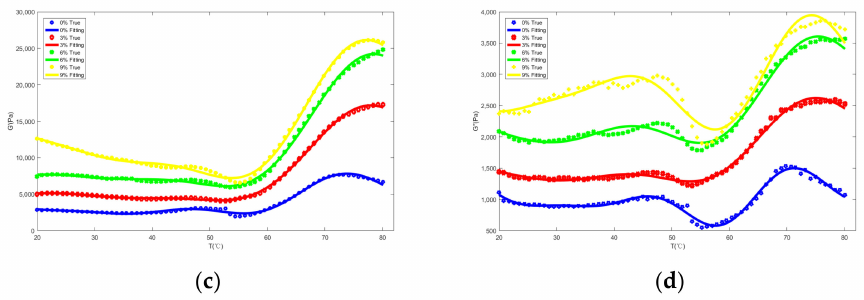
Figure 3. Three-dimensional surface of G (cid:48) ( a ), G (cid:48)(cid:48) ( b ) with a PPI addition level and temperature of DBM and the Fourier function fitting curves between G (cid:48) ( c ) and G (cid:48)(cid:48) ( d ) with the temperature of DBM under a different PPI addition